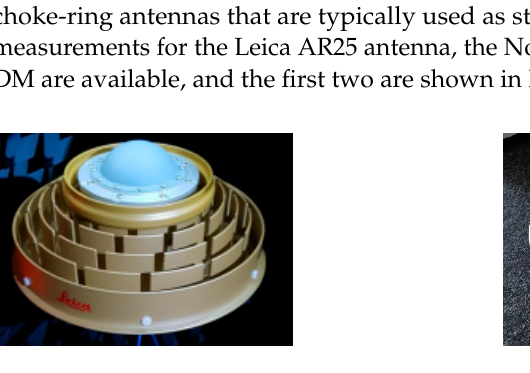
Figure 2. Pictures of Leica AR25 and Novatel GNSS 750.